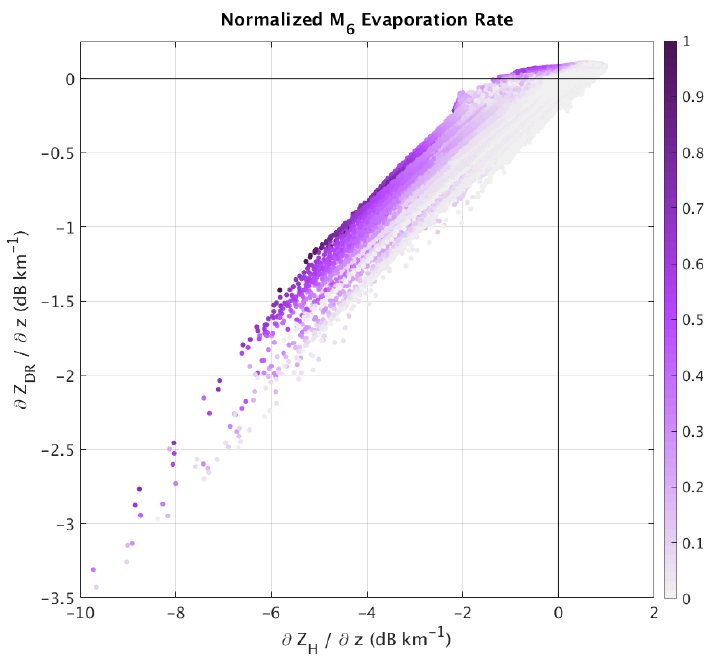
Figure 9. As in Figure 7, but normalized M6 evaporation rate is